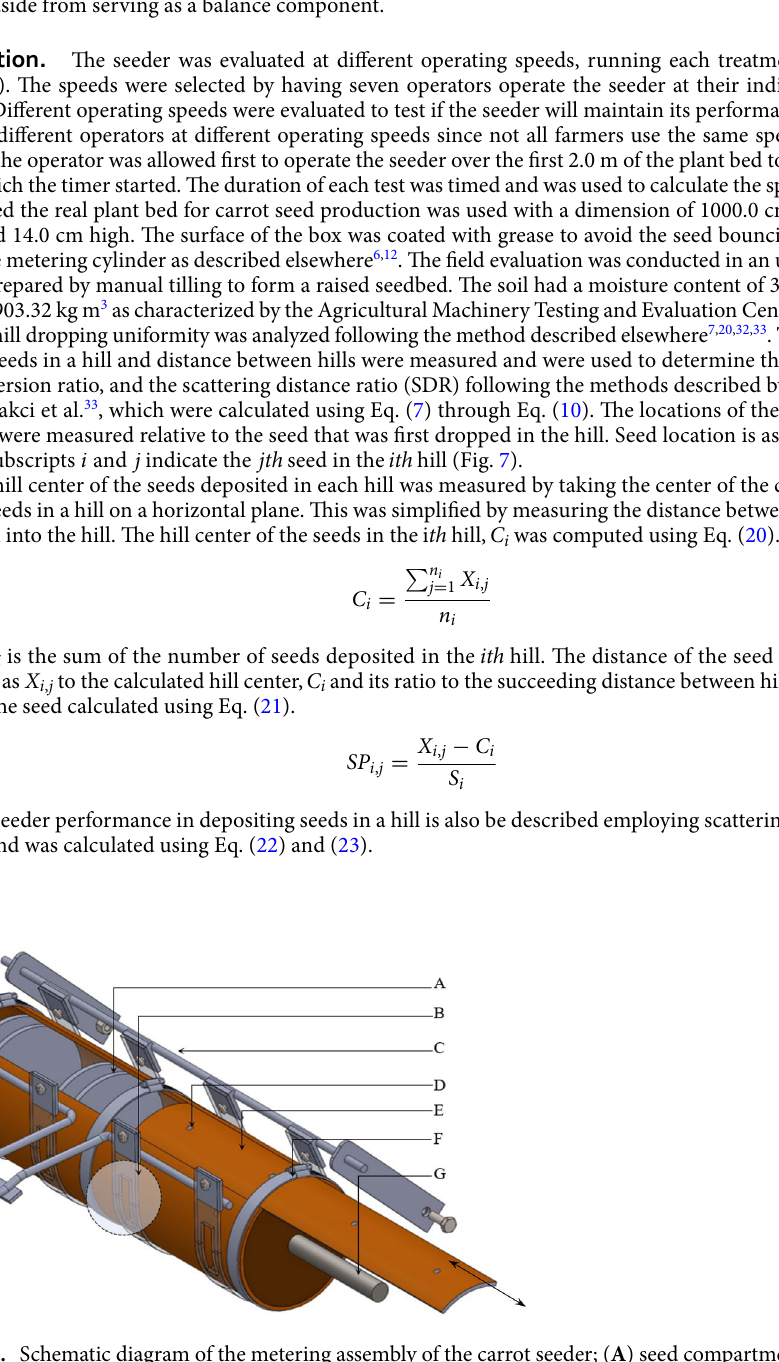
Figure 5. Schematic diagram of the metering assembly of the carrot seeder; ( A ) seed compartment; ( B ) seed discharge hole as earlier illustrated in Fig. 4; ( C ) frame assembly with bolts and nuts; ( D ) seed hole around the circumference of the cylinder; ( E ) removable cover for loading of seeds and removal of excess seeds; ( F ) locking component to lock the removable cover; and ( G ) axle to which the metering cylinder